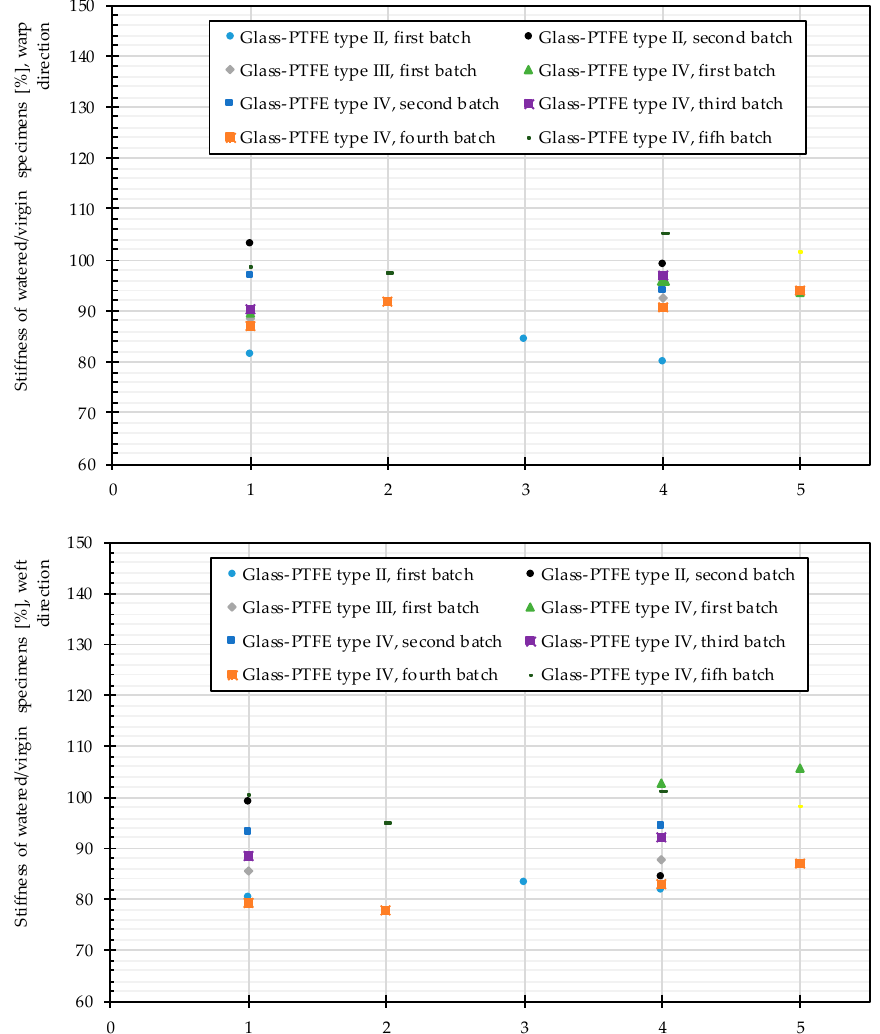
Figure 16. Stiffness changes of glass-PTFE samples according to Table 3 for 1: in-plane and out-of-plane watering (two surfaces), 2: in-plane and out-of-plane watering (two surfaces) without surfactant, 3: out-of-plane watering (one surface), 4: out-of-plane watering (two surfaces), and 5: out-of-plane watering (two surfaces) without surfactant. All are watered for 144 h.